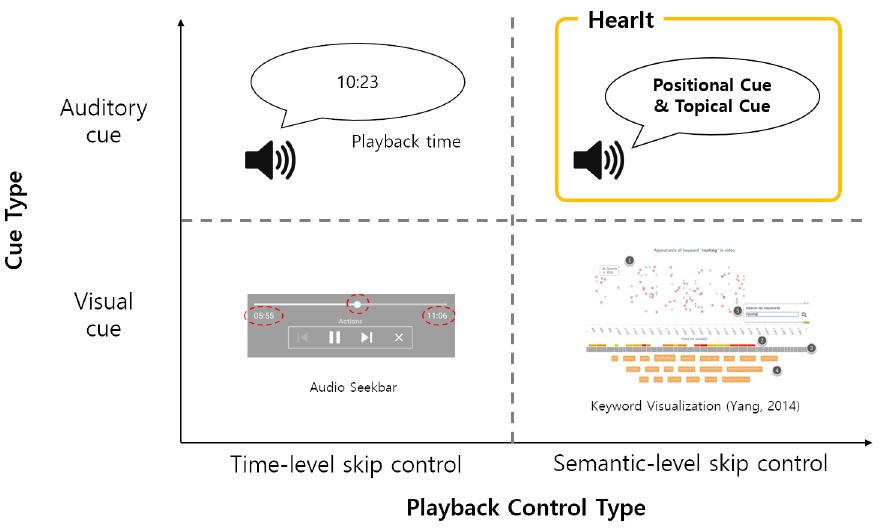
Figure 1. Design space for auditory information